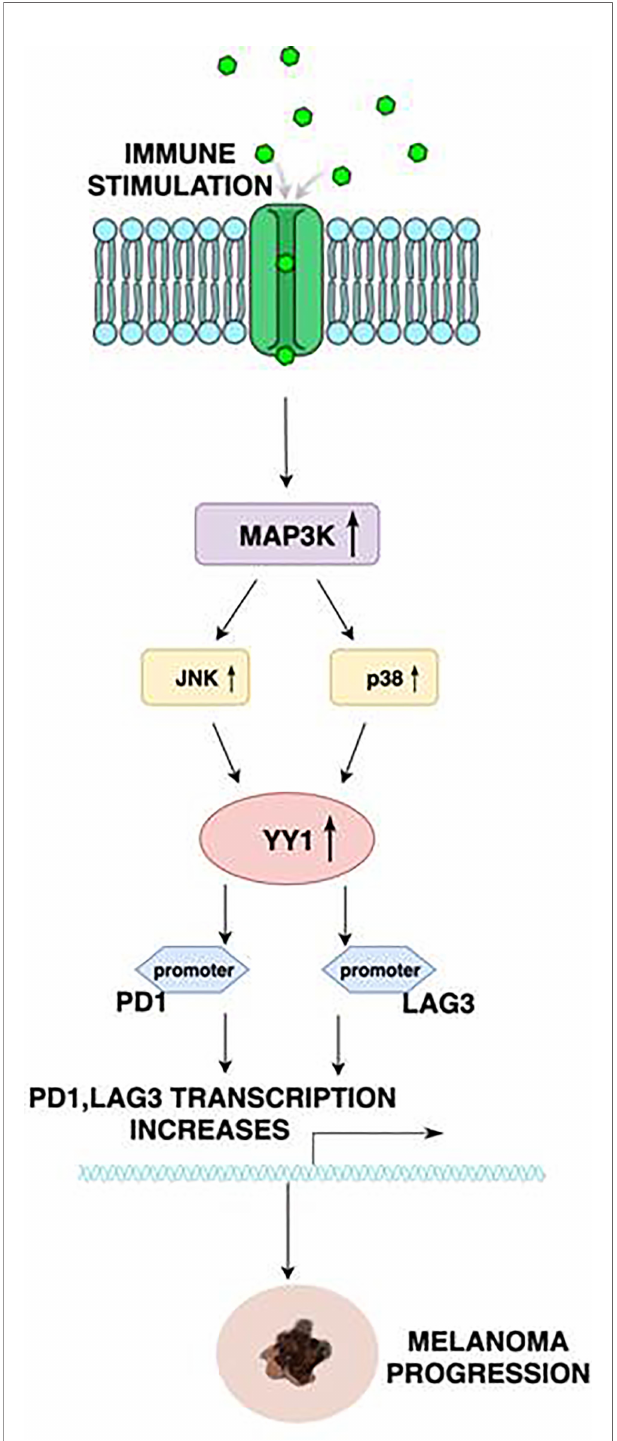
FIGURE 1 | Schematic diagram illustrating the regulation of PD1 and LAG3 by YY1. Stimulation of receptors on the immune cells results in the activation of the MAP3K, leading to the upregulation of JNK and p38. p38 and JNK, in turn, activate YY1. YY1 bind to the PD1 and LAG3 promoters to initiate transcription. This mechanism is correlated with the exhaustion of tumor in fi ltrating T lymphocytes, and thus assists melanoma